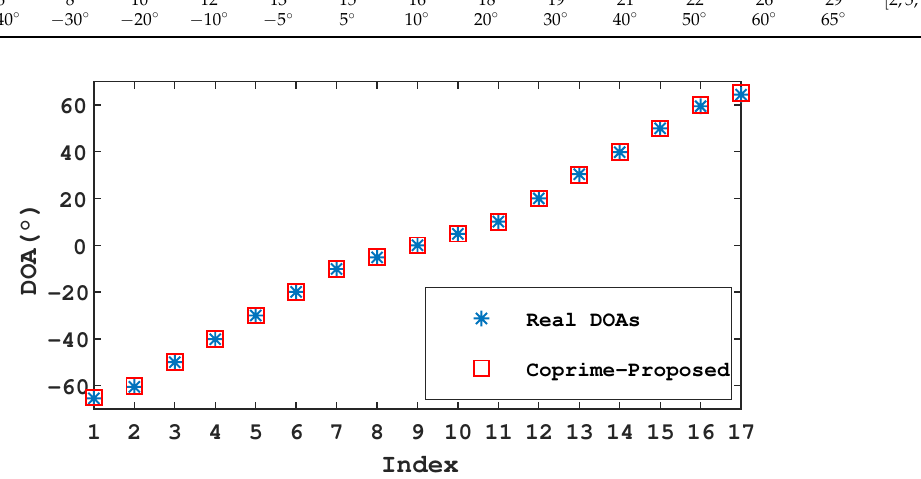
Figure 3. DOF comparison results.